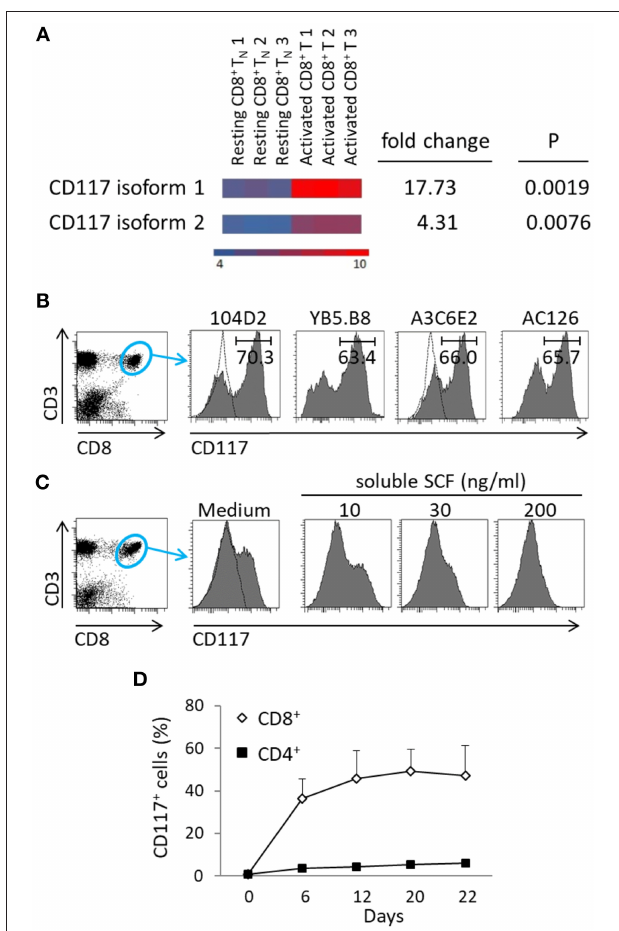
FIGURE 1 | CD117 + expression is induced on CD8 + T cells following recent activation. (A) mRNA transcripts of both isoforms of CD117 are upregulated in enriched CD8 + T N cells from UCB activated with anti-CD3 plus IL-2 for 5 days and then maintained in IL-7 for 2 weeks, as compared to resting T N from UCB. Transcriptome analysis was performed on three different samples for each type of cells. The heat map shows down-regulated genes in blue and up-regulated genes in orange, scale: log2 normalized intensity. (B) CBMC were activated at day 0 and day 12 with anti-CD3 plus IL-2 and at day 21 stained with different clones of CD117-specific MoAbs, as indicated. Histograms show the results of gating on CD3 + CD8 + cells. The dotted lines indicate the isotype controls, one for each company, since the antibodies are all IgG1. A single representative experiment out of three is shown. (C) CBMC at day 7 after activation were incubated overnight with escalating doses of soluble SCF and the expression of CD117 was then determined. Histograms show the results of gating on CD3 + /CD8 + cells. A single representative experiment out of three is shown. (D) CBMC were activated with anti-CD3 plus IL-2 and the kinetics of CD117 expression was recorded, gated on either CD3 + CD8 + or CD3 + CD4 + cells. Data are from six independent cord blood